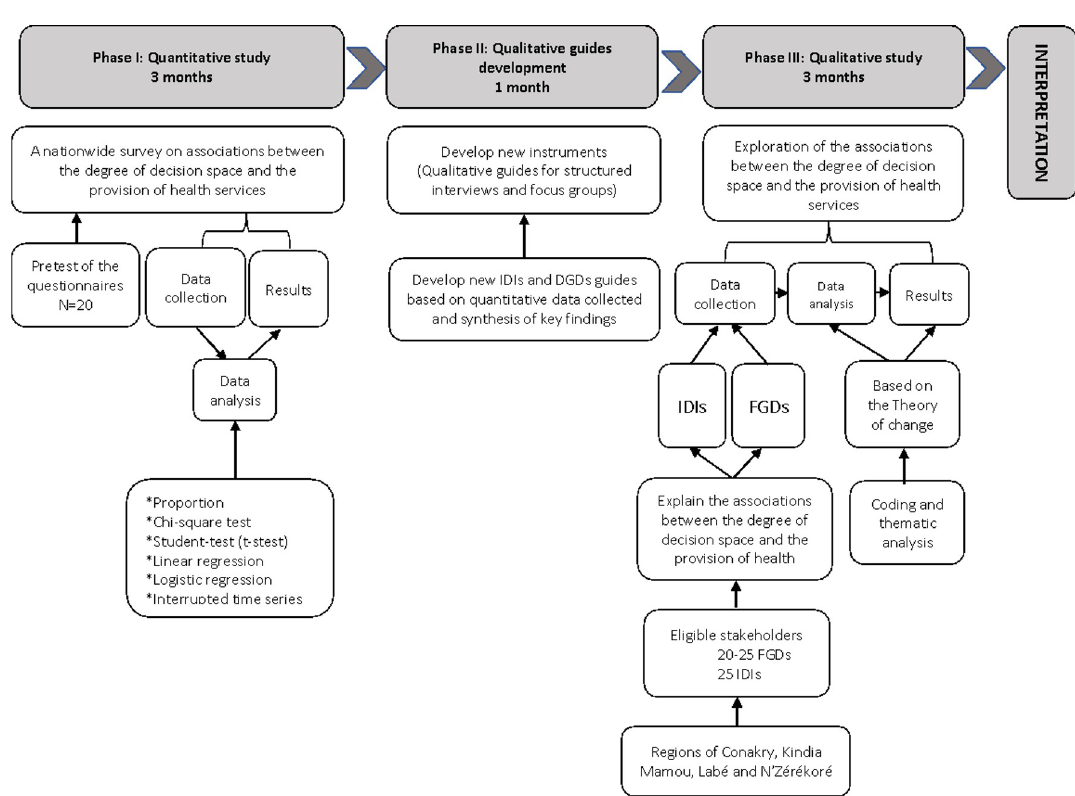
Fig 2. Decision space sequential mixed study